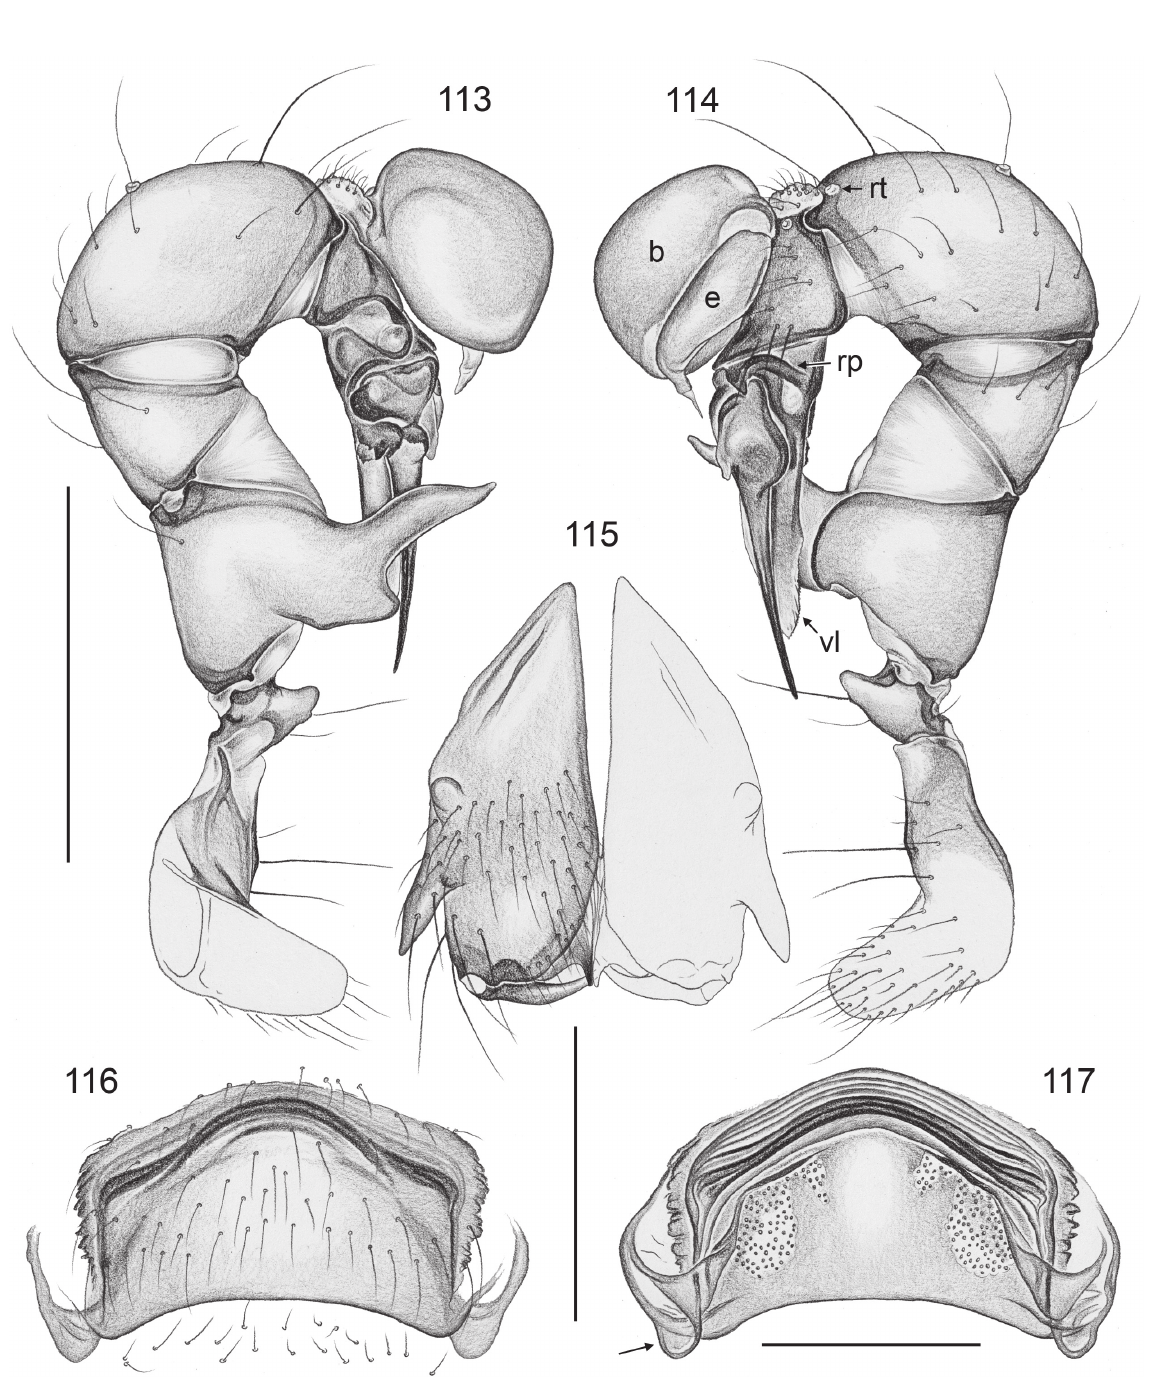
Figs 113–117. Aetana lambir Huber, sp. nov. 113–114 . Left male palp, prolateral and retrolateral views. 115 . Male chelicerae, frontal view. 116–117 . Cleared female genitalia, ventral and dorsal views (arrow points at membranous pocket). b = genital bulb; e = embolus; rp = retrolatero-ventral process; rt = retrolateral trichobothrium; vl = ventral lamina. Scale lines: 113–114 = 0.5 mm; 115–117 =